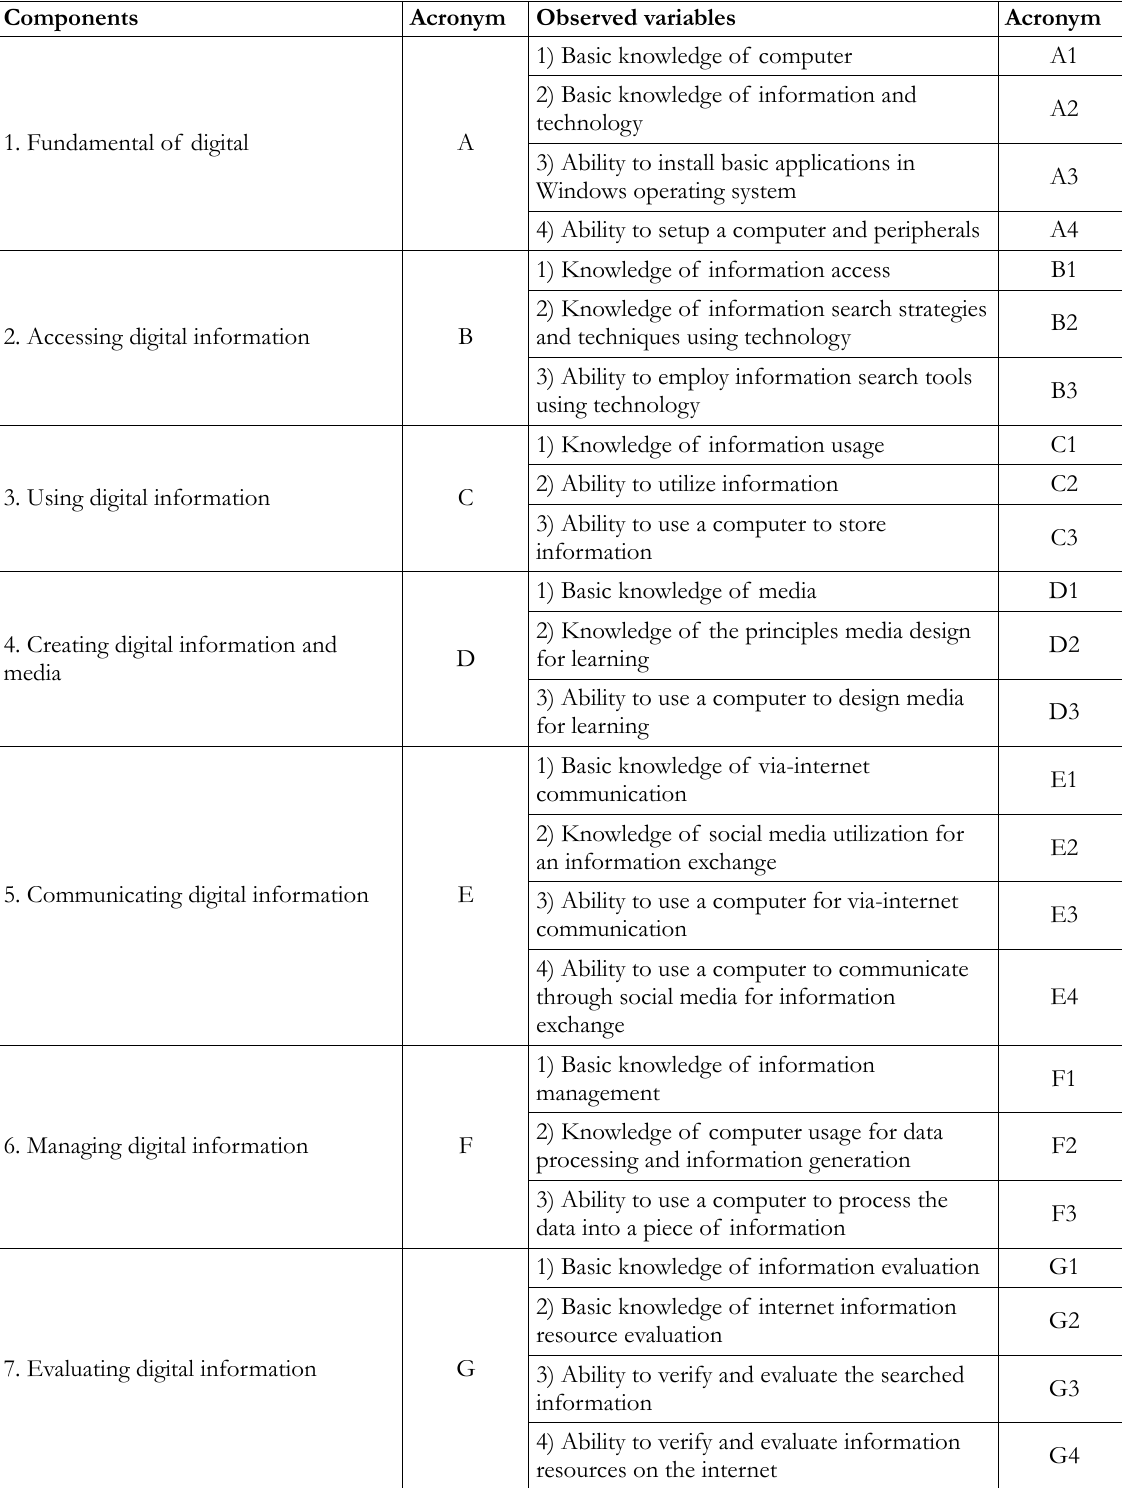
Table 2. Component definitions and observed